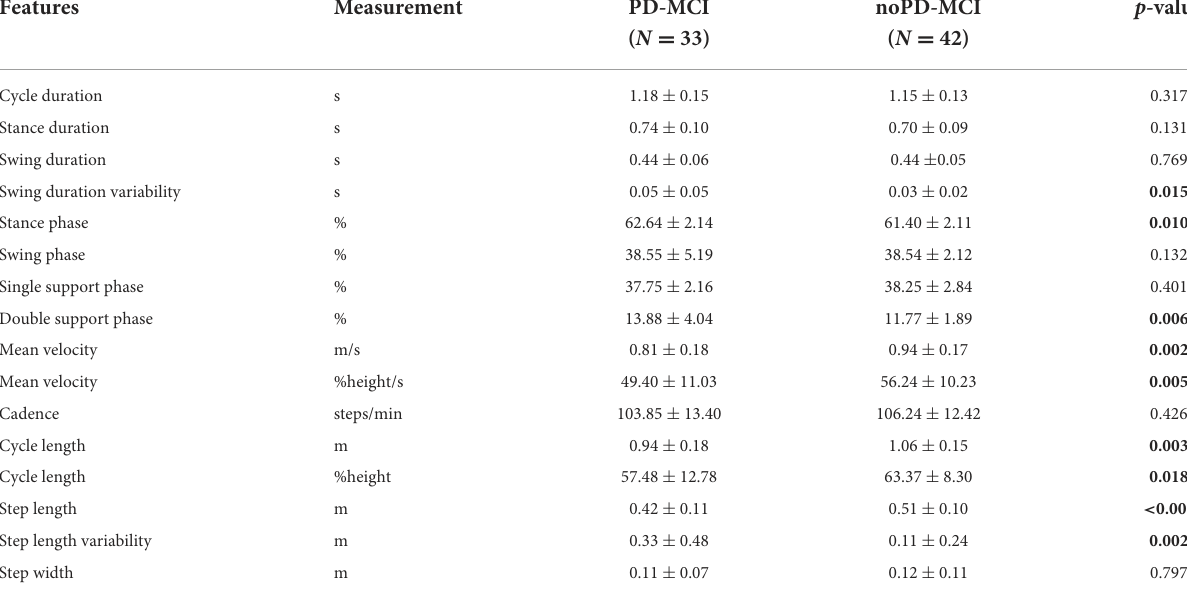
TABLE 2 Comparison of spatial and temporal gait parameters during the COG task between PD-MCI and noPD-MCI patients. Features